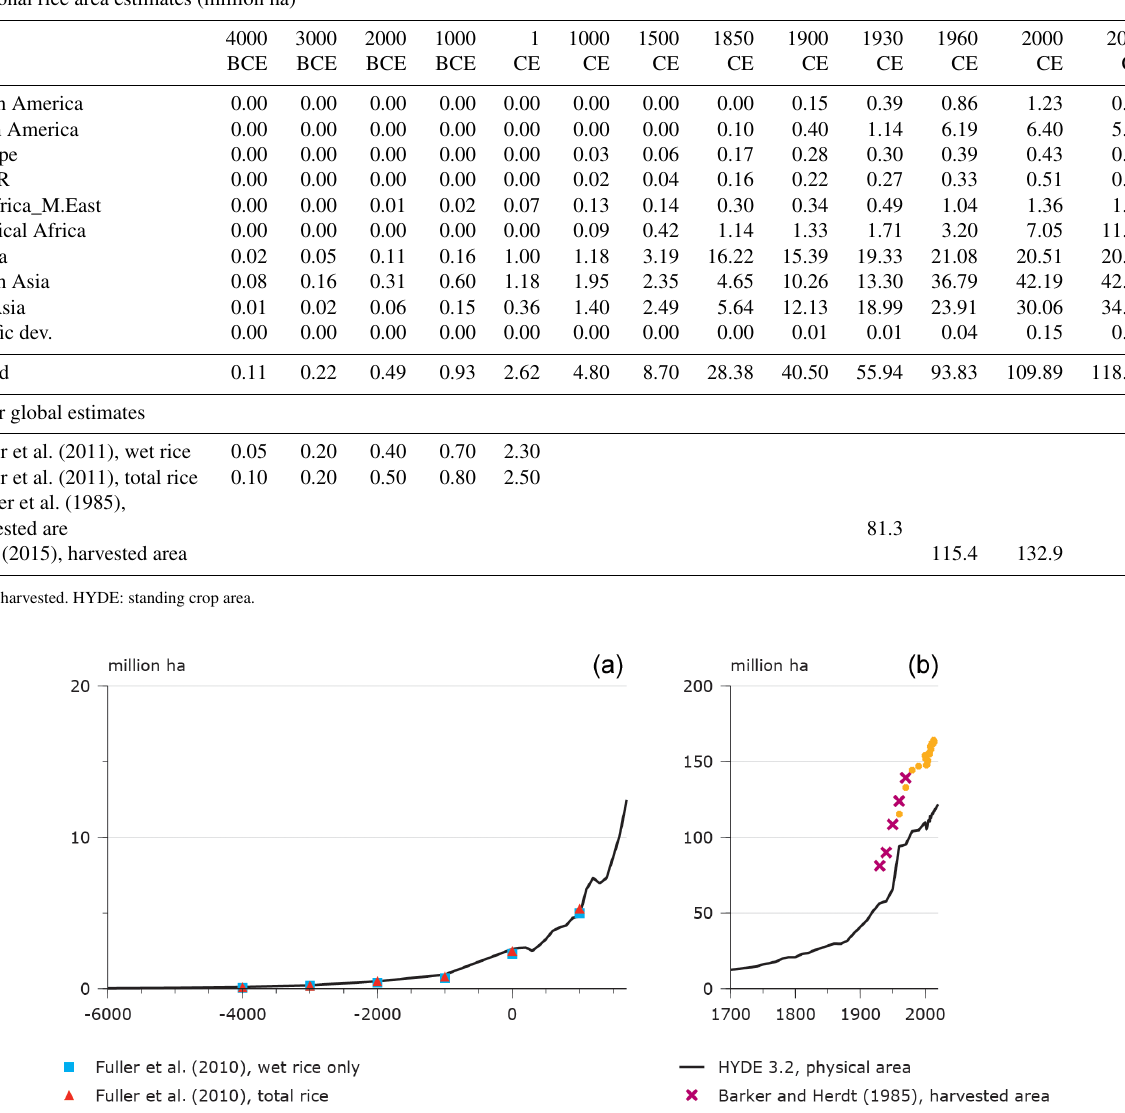
America, and to a lesser extent in China. In North Amer- ica and China, it seems to have stabilized in the last 10 to had its peak around 1900 CE and is still declining